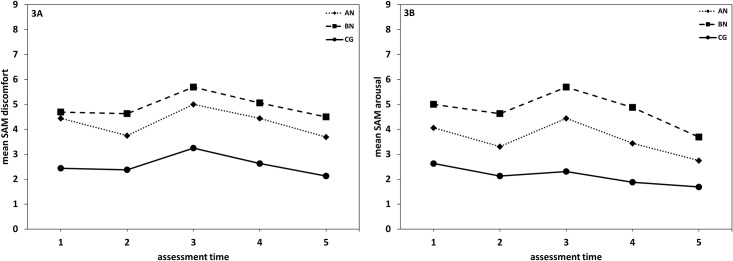
Time course of discomfort and arousal.Time course of SAM discomfort (Fig 3A) and arousal (Fig 3B) in patients with anorexia nervosa (AN), bulimia nervosa (BN) and the healthy control group (CG). Time points: 1 = at beginning, 2 = after relaxation, 3 = after body exposure, 4 = after changing (approx. 10 min after body exposure), 5 = at termination (approx. 35 min after body exposure). Scale: SAM discomfort: 1 = very comfortable, 9 = very uncomfortable; SAM arousal: 1 = lowly aroused, 9 = highly aroused.